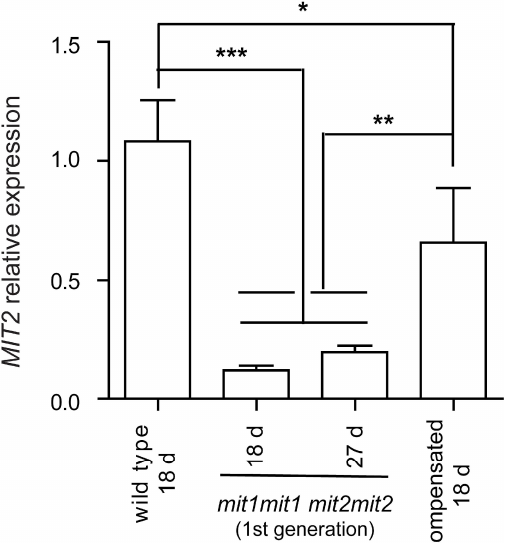
Figure 7. MIT2 expression in double homozygous mutant plants. MIT2 mature transcript levels were determined by RT-qPCR and normalized to TIP41-like transcript levels. Means ± SD of four biological replicates is shown. RNAs were prepared from seedlings at stages 1.03–1.04 [26], i.e., 18 day old seedlings for wild type and “compensated” double homozygous mutant plants ( mit1-1mit1-1 mit2-1mit2-1 ) and 27 day old seedlings for the first generation of the double homozygous mutant plants (same developmental stage), and also from 18 day old seedlings from these last plants (stage 1.0). The primers used for MIT2 were primers 20 (encompassing exon junction) and 21 (Supplemen ‐